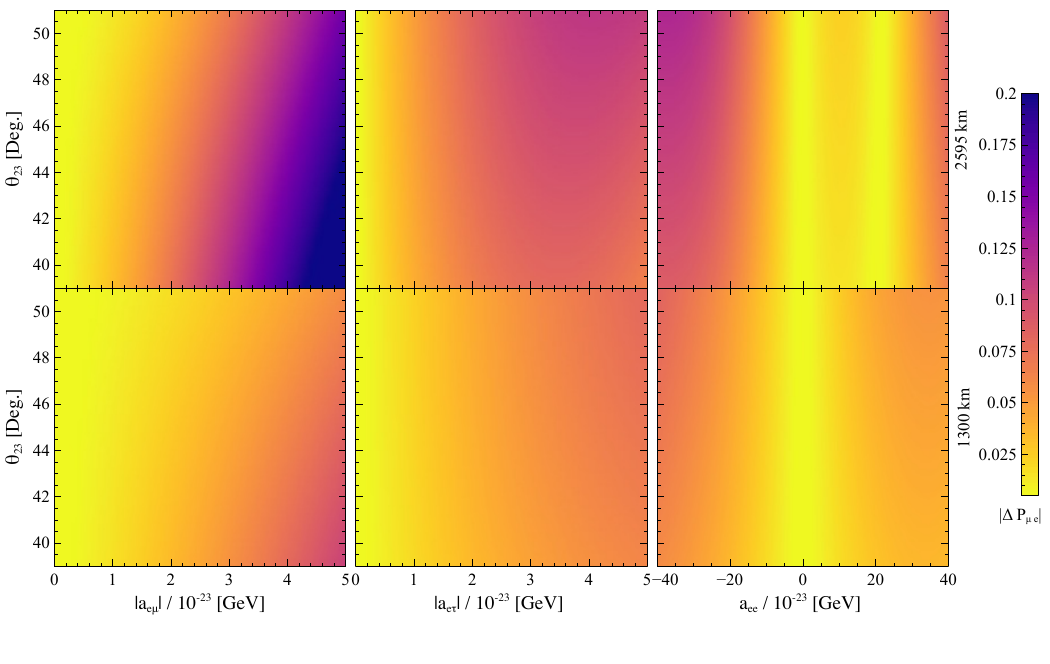
Figure 4 . Similar to figure 2 but shown as a function of θ 23 with fixed δ 13